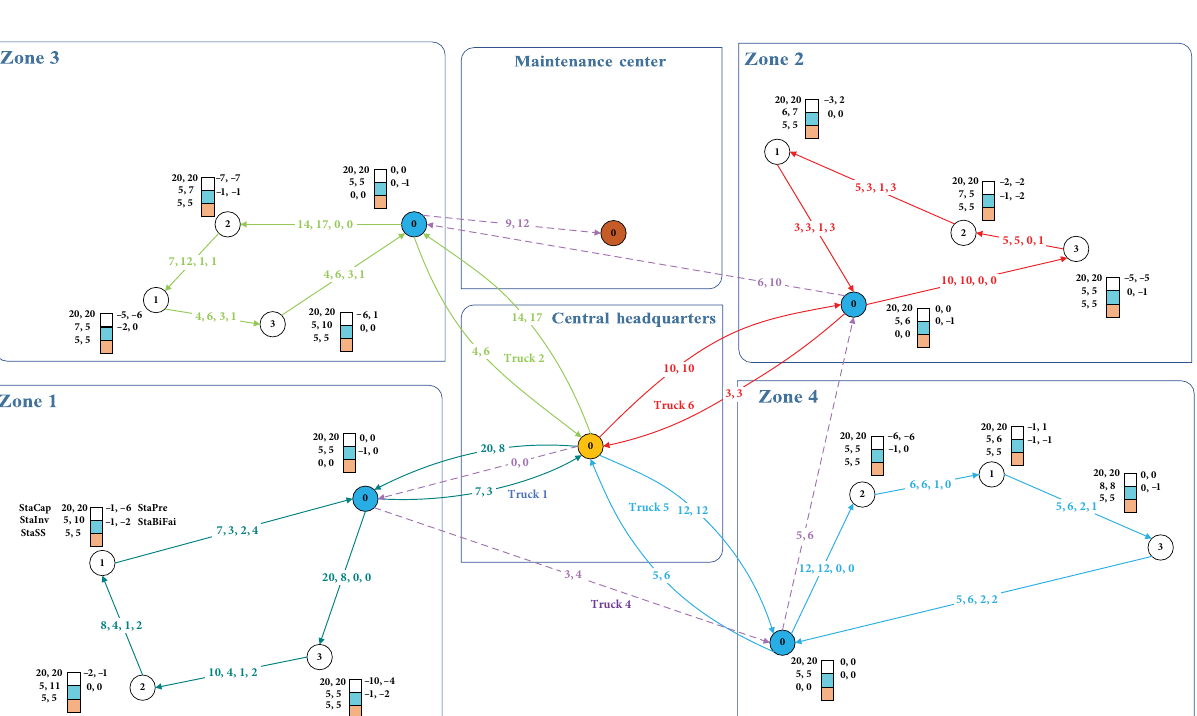
Figure 3. Result of solving numerical example 1